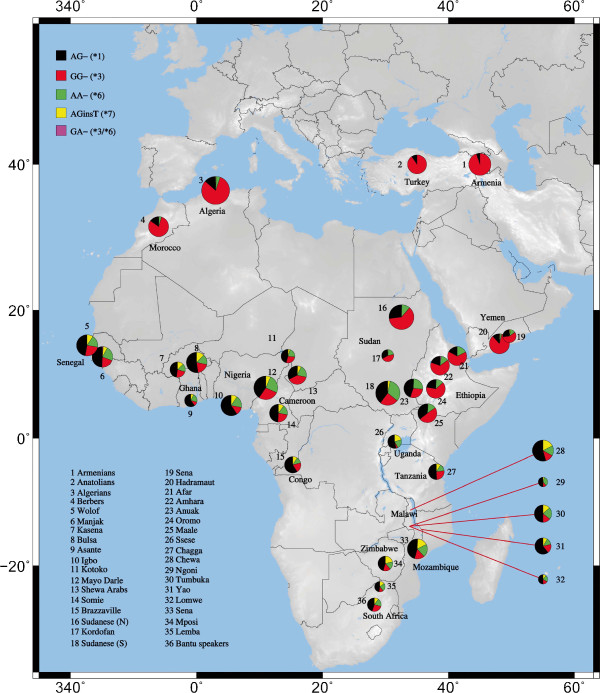
The distribution of the five inferred CYP3A5 haplotypes across the dataset. The size of each circle is proportional to the number of individuals sampled from a given population (see Additional file 1 Table S1). The allele combinations at all three loci are given in the key. The alleles in brackets define the inferred haplotype. N.B. the recombinant CYP3A5 haplotype 5: *3/*6, is observed at low frequency in the dataset.